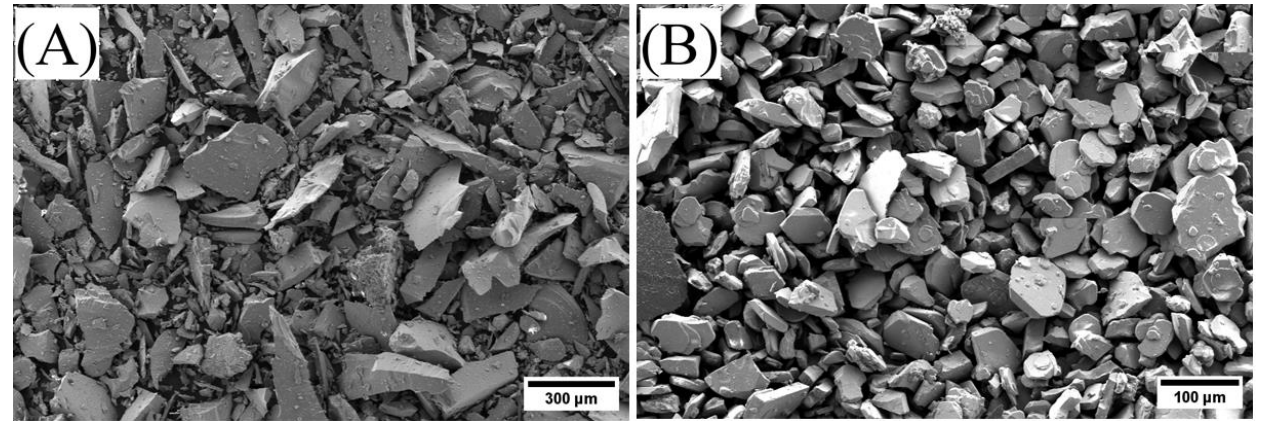
Figure 1. Glass frit powder as received ( A ). Alumina platelets (50 µm) as received ( B ).